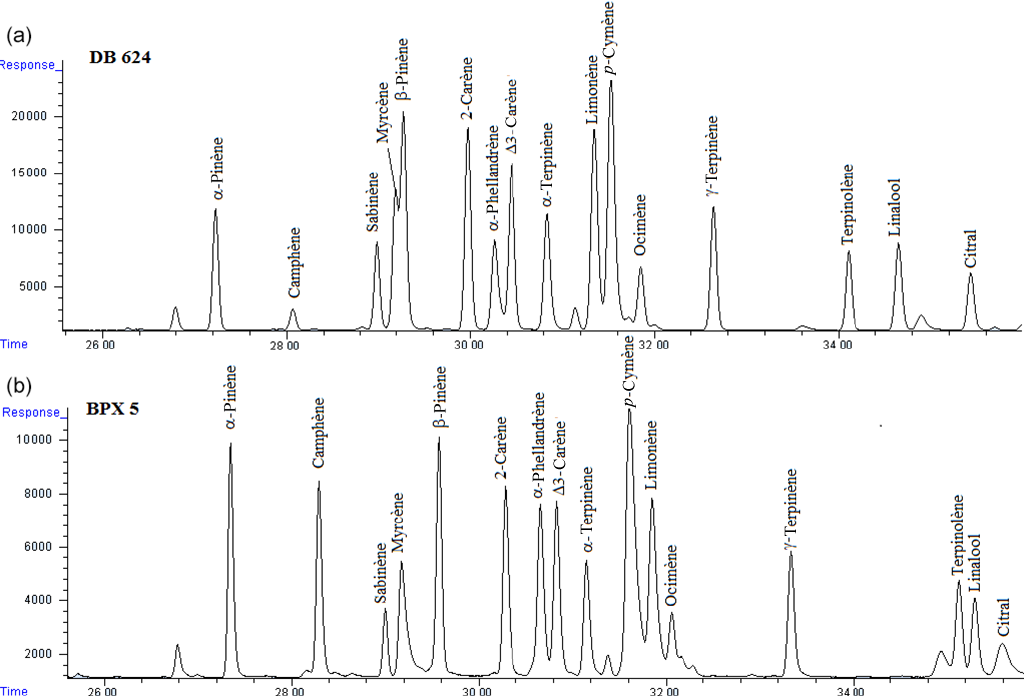
Figure 1. Separation of the 20 BVOCs from Table 2 using the DB-624 column (a) and the BPX5 column (b) . VOC mixing ratios were approximately 1ppb.